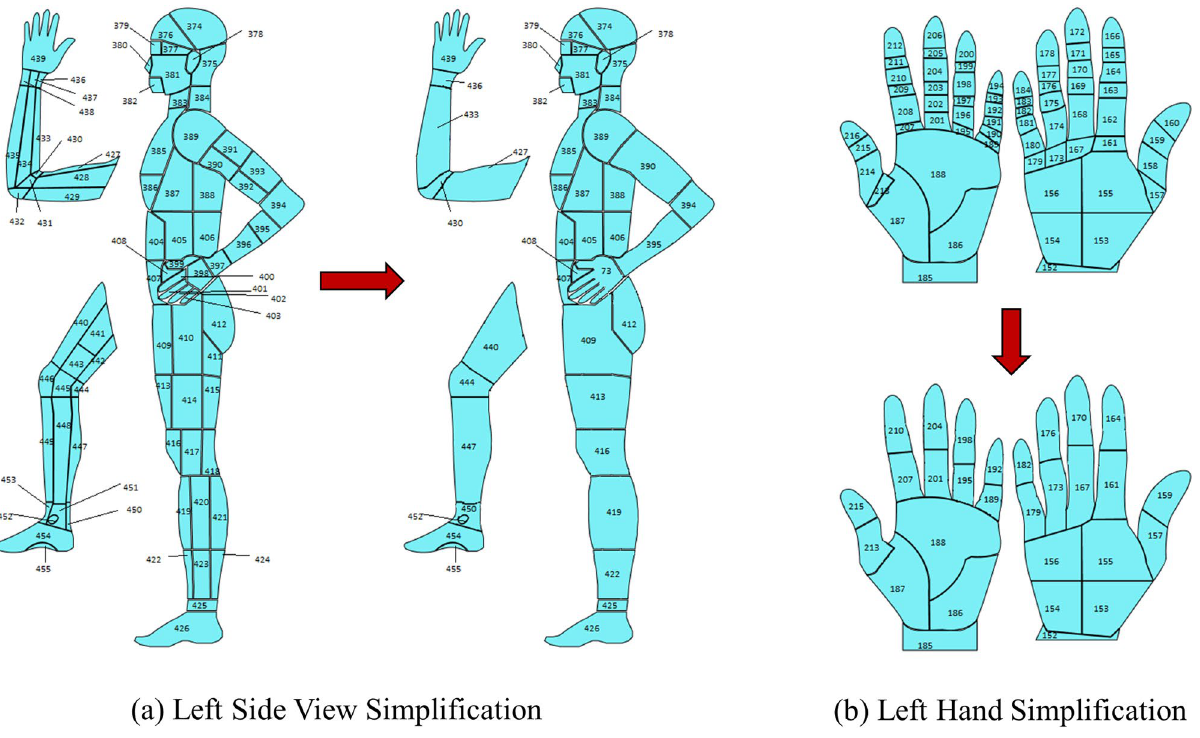
Figure 3. Body map